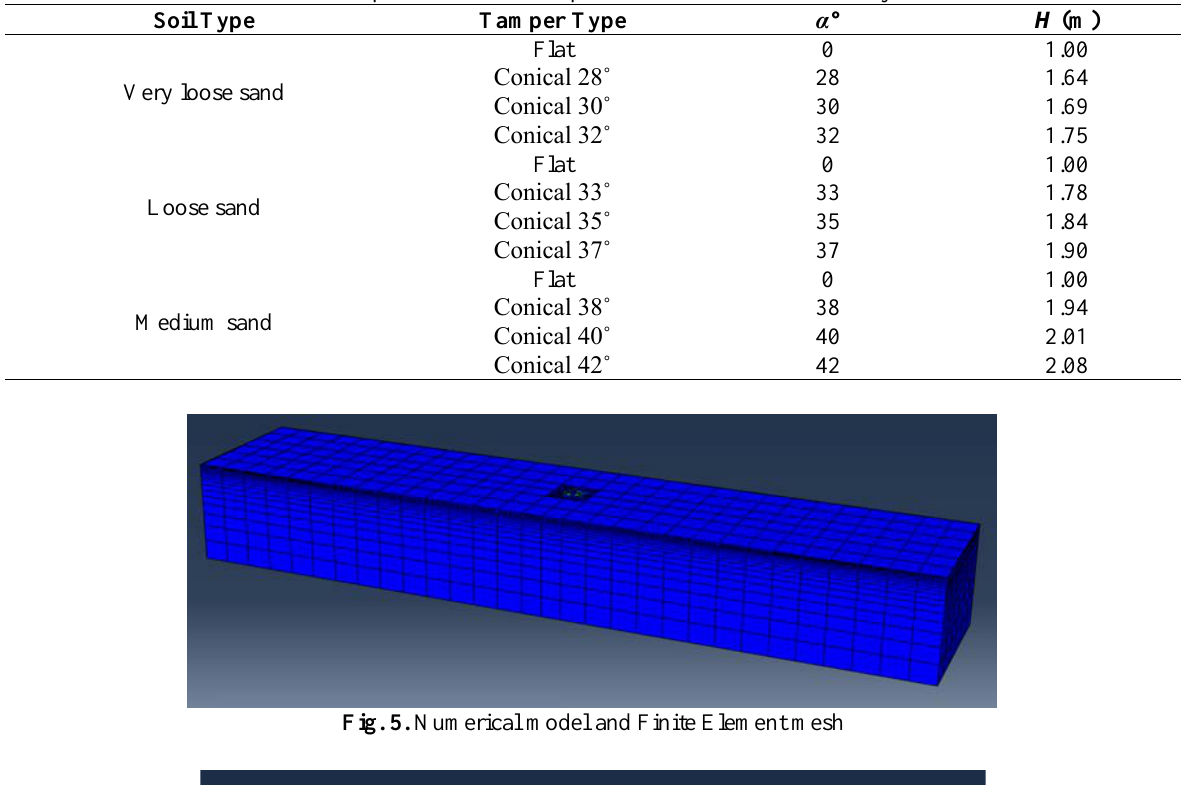
Fig. 5. Numerical model and Finite Element mesh